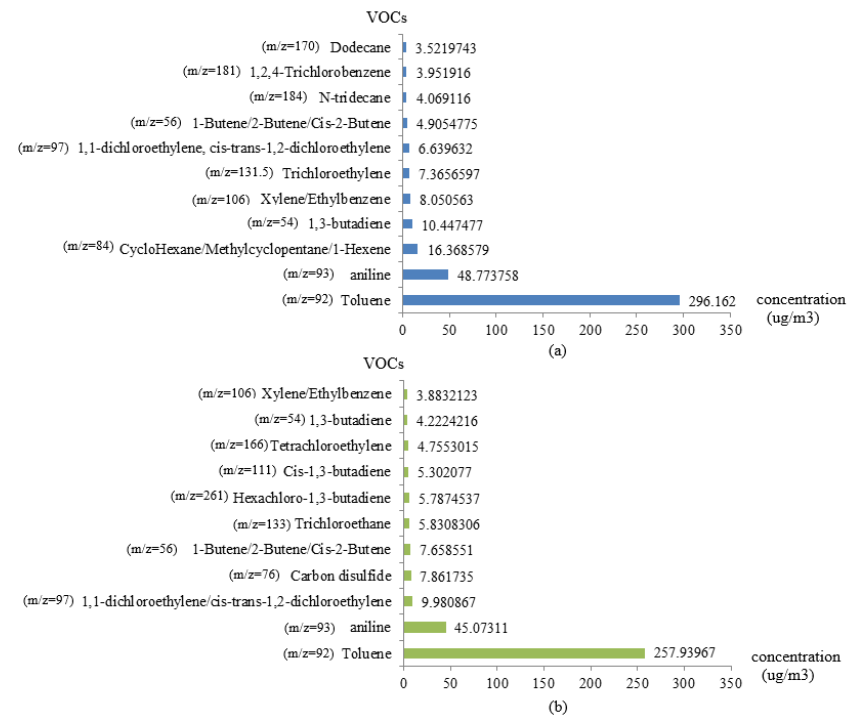
Figure 6. Substances with higher VOC concentrations in both study areas. ( a ) The navigation data near the Qianhui Pharmaceutical premises. ( b ) The navigation data near the Naxin Daily Necessities premises.